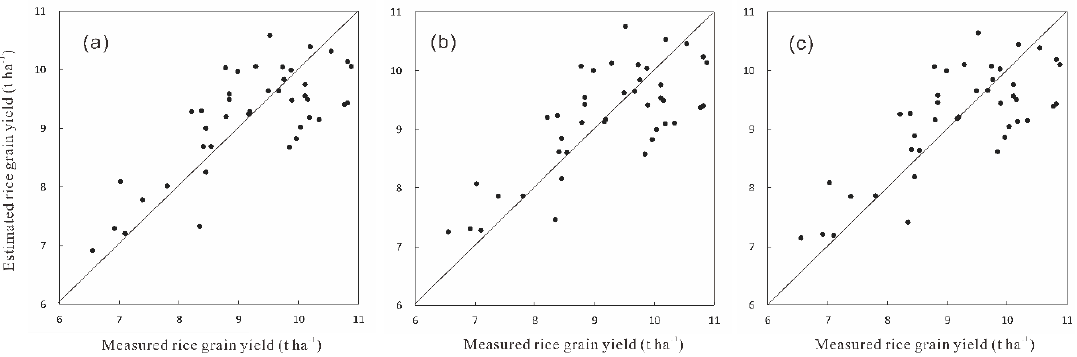
Figure 5. Comparison between the measured rice grain yield and the grain yield estimated from the leave-one-out cross-validation (LOOCV) using SSD VH (a), SSR VH (b) and SND VH (c), respectively. The diagonal lines showed the 1:1 relationship.